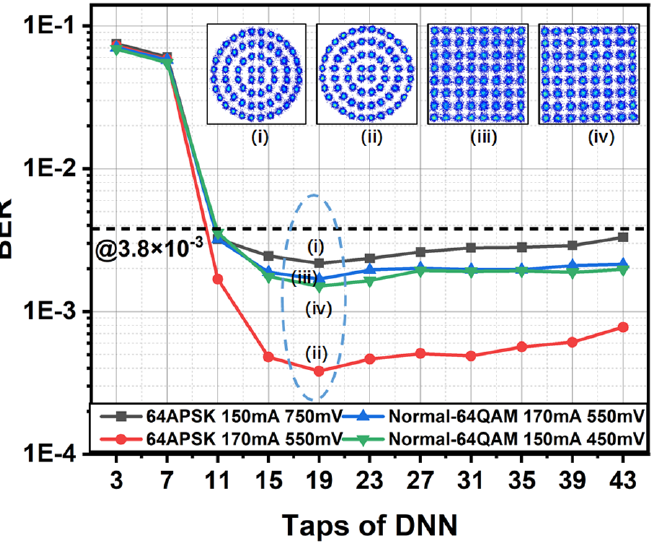
Figure 3. The relationship between BER performance and the taps of traditional DNN-based waveform-to-symbol converter under different bias currents and signal Vpp. ( i – iv ) show the constel- lation points of 19 taps under different bias currents and signal Vpp respectively.